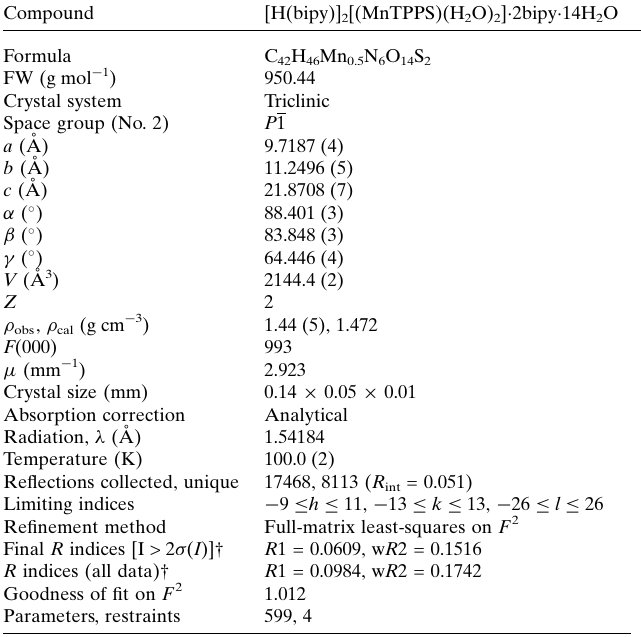
Table 1 Crystallographic data for 1 .